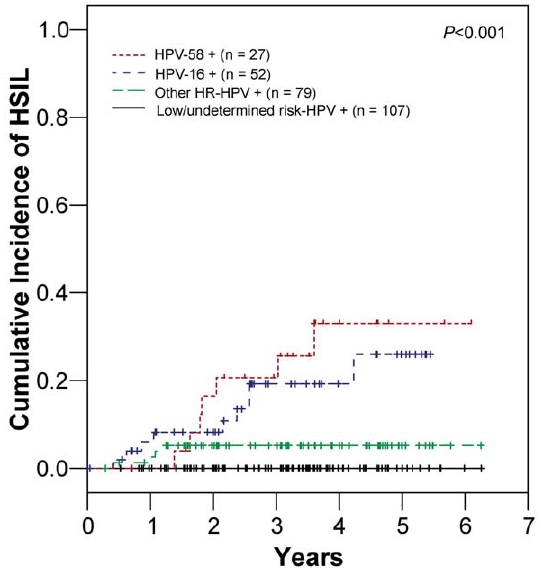
Figure 2. Cumulative incidence rates of high-grade squamous intraepithelial lesions (HSIL) according to the HPV genotypes. Women with HPV-positive and cytology-negative results were classified into 4 groups depending on the HPV genotype detected on the first examination. Significant differences in the incidence of HSIL were found between the 4 groups. Note that there is a higher risk of development of HSIL in women with HPV-58 infection.